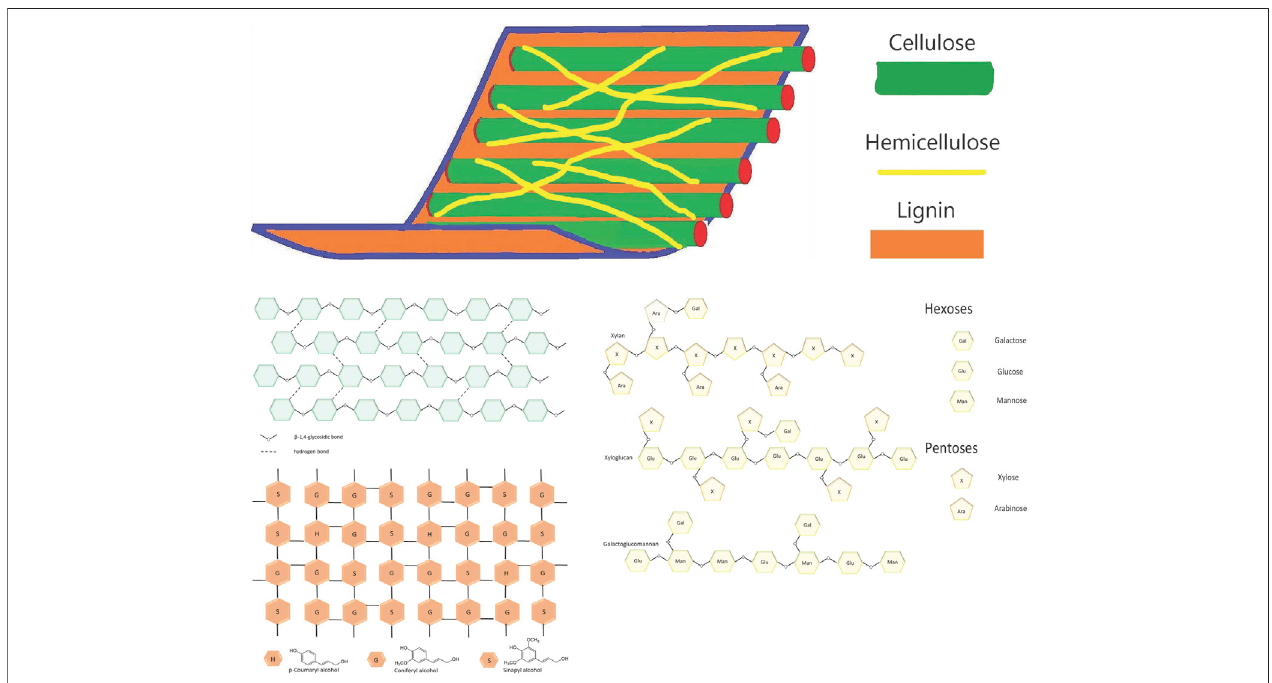
FIGURE 4 | Sketch of lignocellulose